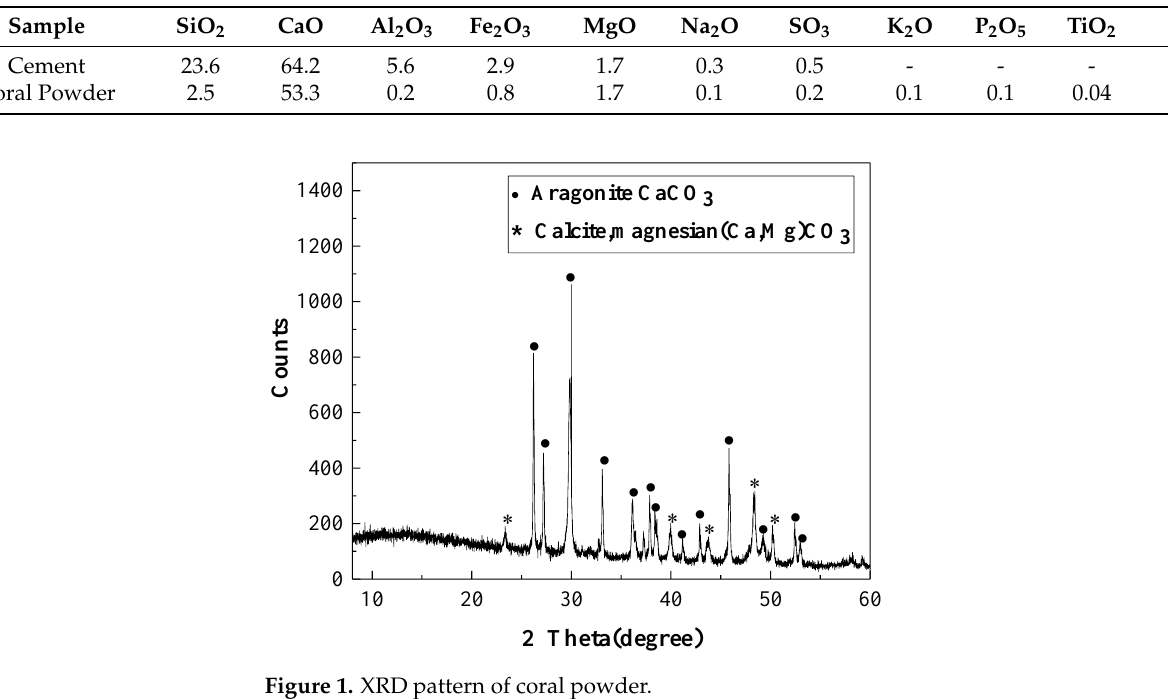
Figure 1. XRD pattern of coral powder.